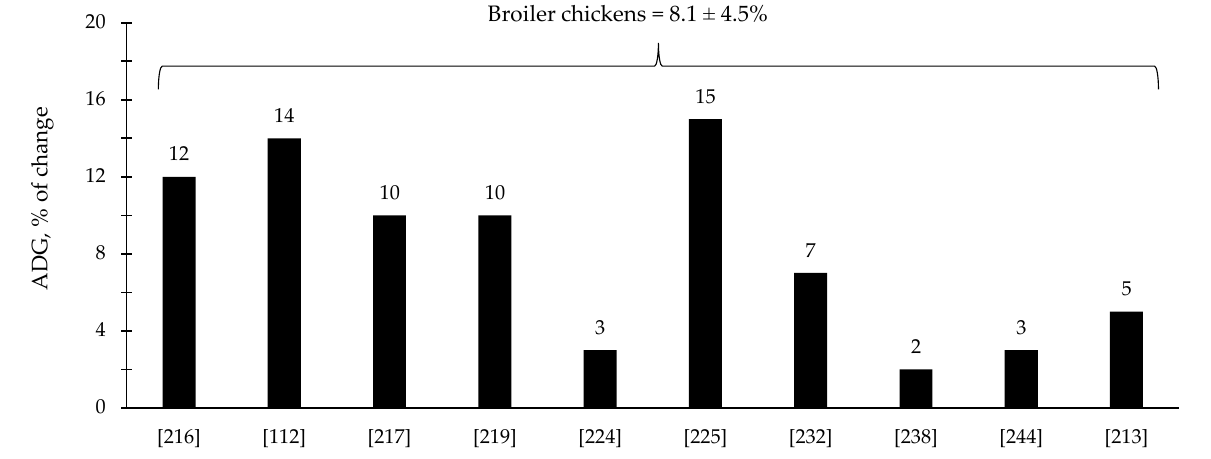
Figure 5. Changes in the average daily gain (ADG) of broiler chickens by xylanase supplementation among the studies displayed in Table 3 that showed changes in the ADG. The studies were selected from peer-reviewed literature available after 2000. The percentage of change refers to a statistically significant ( p < 0.05) and tendency (0.05 ≤ p < 0.10) effects of xylanase individually on the ADG reported from each respective study. The described effects were in comparison with treatments containing no xylanase. The average changes in the ADG of broiler chickens by xylanase supplementation were calculated excluding the studies that showed no effect. Nursery pigs = 9.8 ± 4.7%